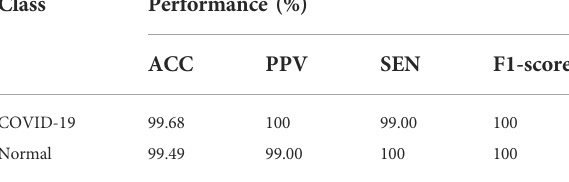
TABLE 4 Experimental results obtained by the proposed model for COVID-19 and normal cases on X-rays.